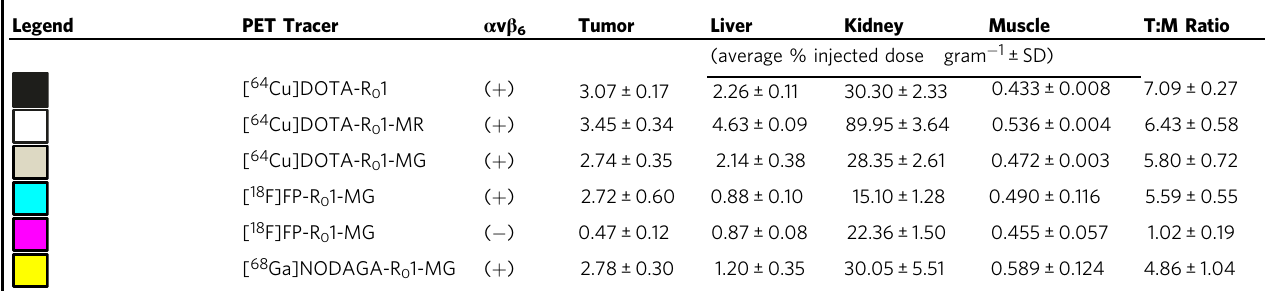
Table 3 PET quanti fi cation table